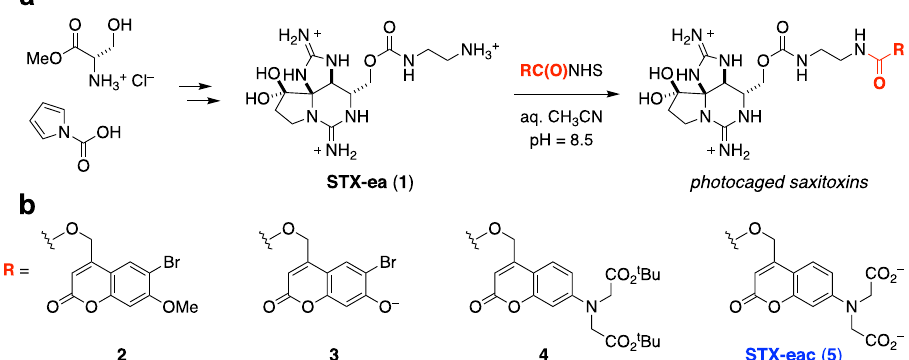
Fig. 1 Caging STX-ea 1 with photo-protecting groups. a Synthesis and selective carbamoylation of STX-ea 1 . b Photocaged derivatives of